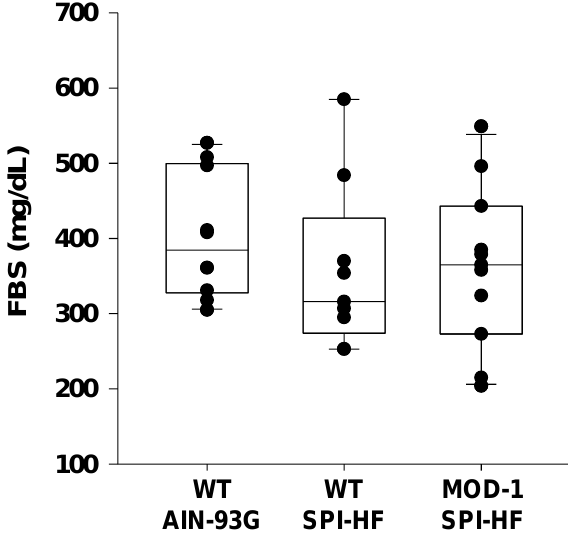
Figure 2. Fasting blood glucose (FBS) levels of experimental mice did not differ at study termination. Groups: n = 11 WT AIN-93G; n = 9 WT SPI-HF; n = 10 MOD-1 SPI-HF. Dots represent values for individual mice. Box plots indicate the upper and lower quartiles, interquartile range, and median (middle line), with whiskers showing maximum and minimum points within 1.5 × the interquartile range. There were no significant group differences or tendencies.